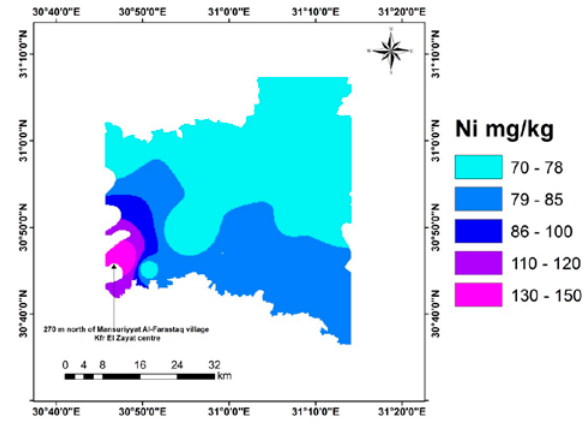
Fig. 6. Spatial interpolation of the weighted mean of nickel